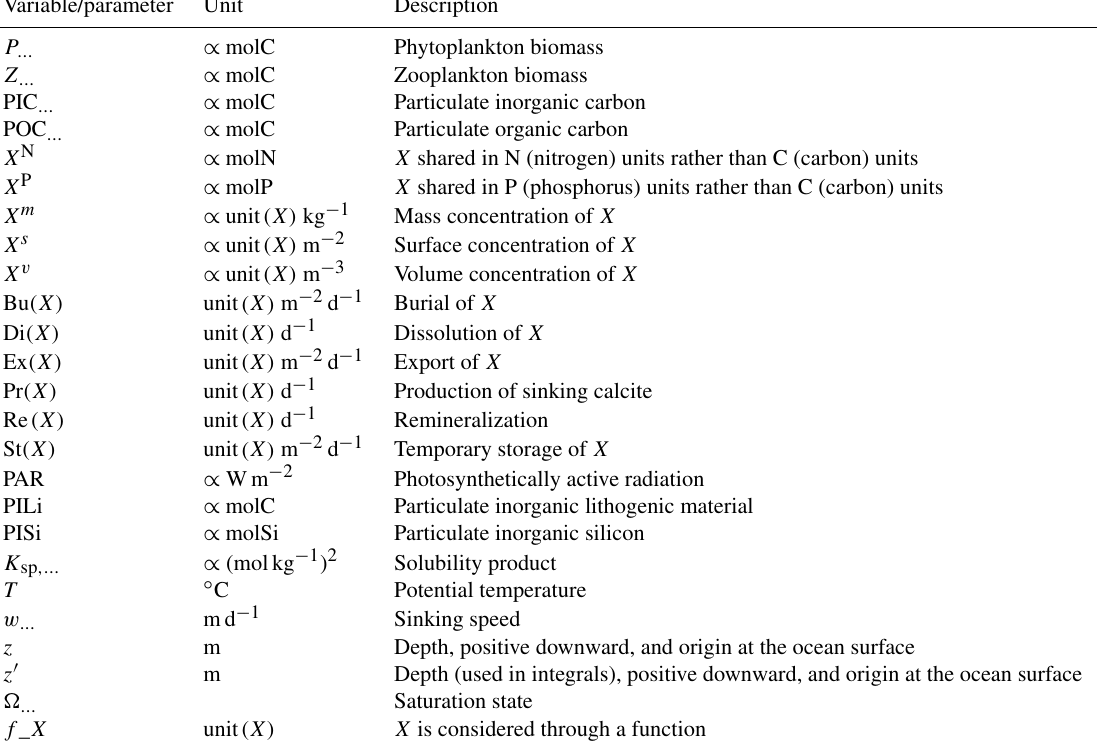
Table C1. Definitions of general model variables and parameters. Variable/parameter